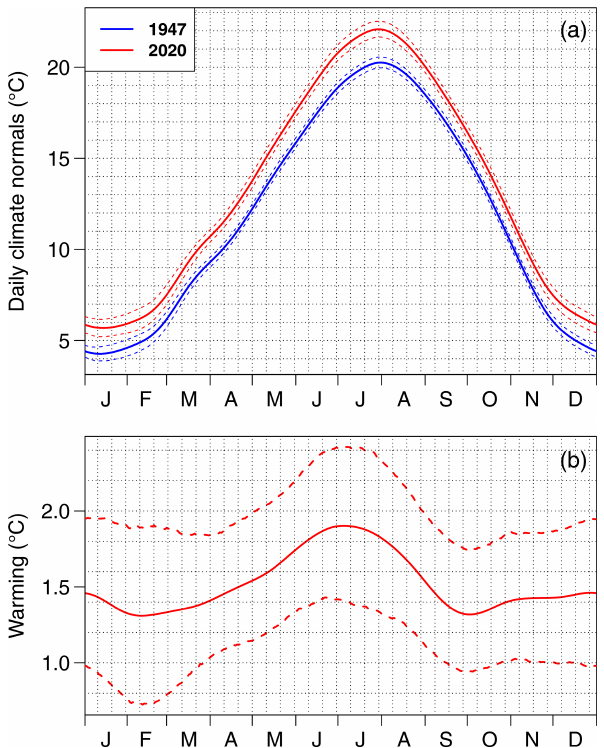
Figure 4. Changing climate normals. (a) Daily climate normals for the daily mean temperature over France estimated in 1947 and 2020 following the methodology of Rigal et al. (2019). (b) Difference be- tween the 1947 and 2020 climate normals, i.e., 1947 to 2020 warm- ing as a function of the time of the year. Dashed lines provide boot- strap 5%–95% confidence ranges ( a , b